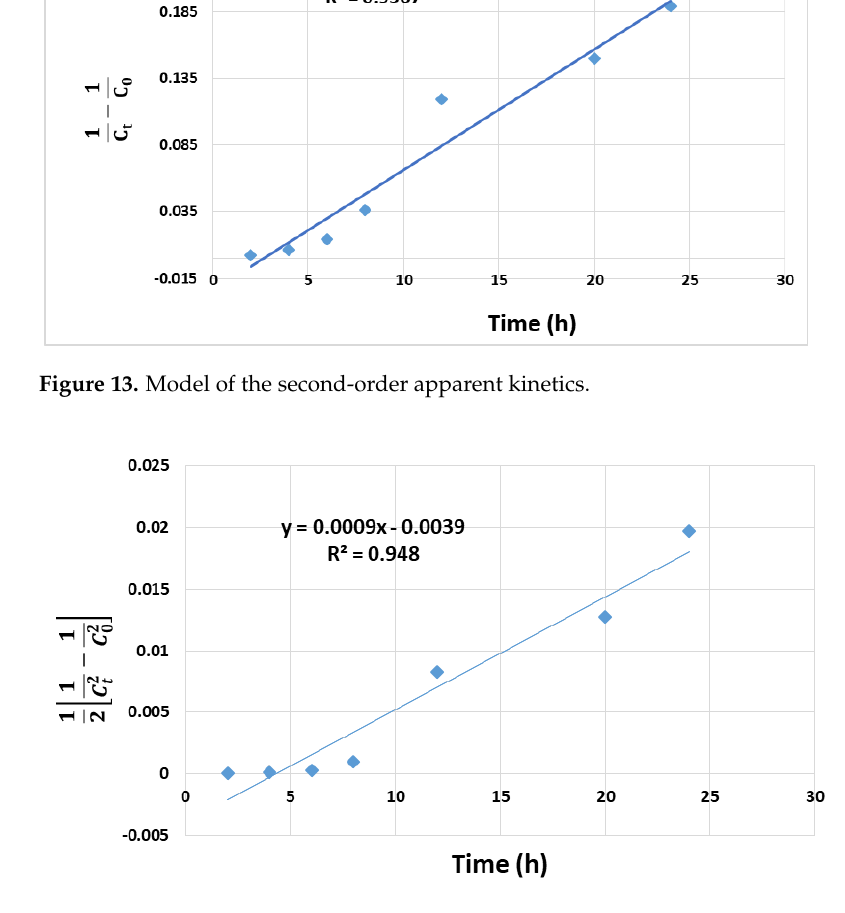
Figure 14. Model of the third-order apparent kinetics.